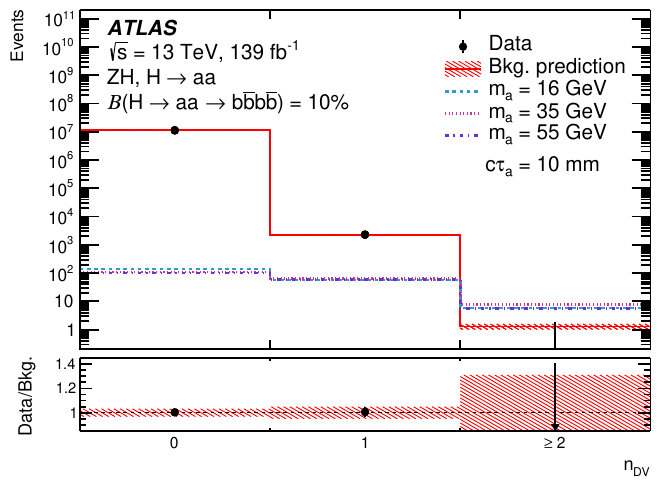
Figure 5 . DV multiplicity among preselected events for signal (dashed lines), background prediction (solid line), and data (black points). The bins corresponding to n DV = 0 and n DV = 1 compose the CR, which is used to derive the background estimate. The third bin is the SR and contains all events with n DV ≥ 2 . The shaded bands represent the combined statistical and systematic uncertainty of the prediction. Signal distributions are normalized assuming B ( H → aa → b ¯ bb ¯ b ) = 10% .